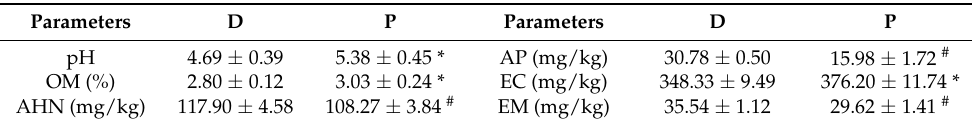
Table 3. The effect of prochloraz on rhizosphere soil pH and physical and chemical properties of decline-diseased bayberry.